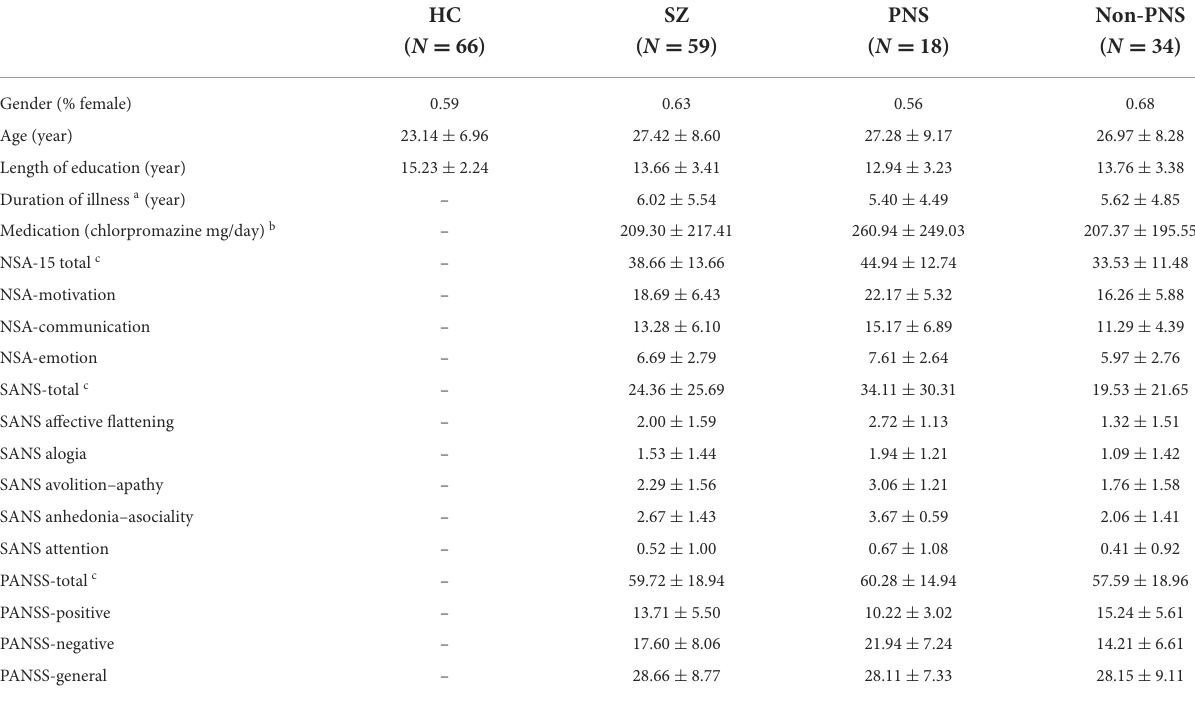
TABLE 1 Demographic information and clinical symptoms.